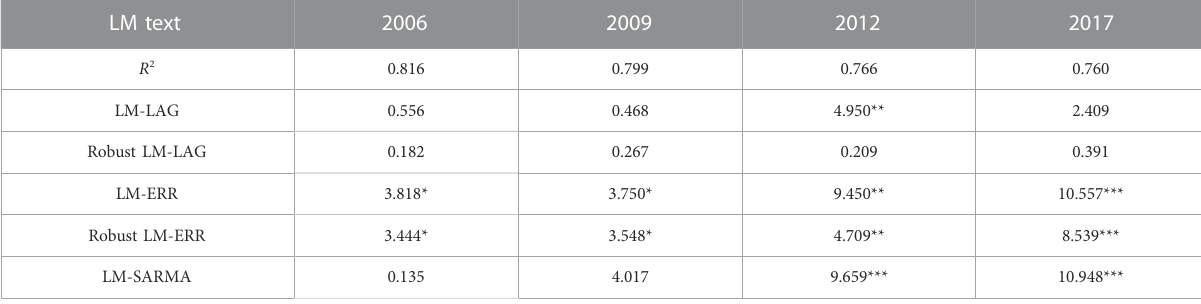
TABLE 4 OLS Estimates of GDP in the 13 provinces of North China (2006, 2009, 2012, and 2017).